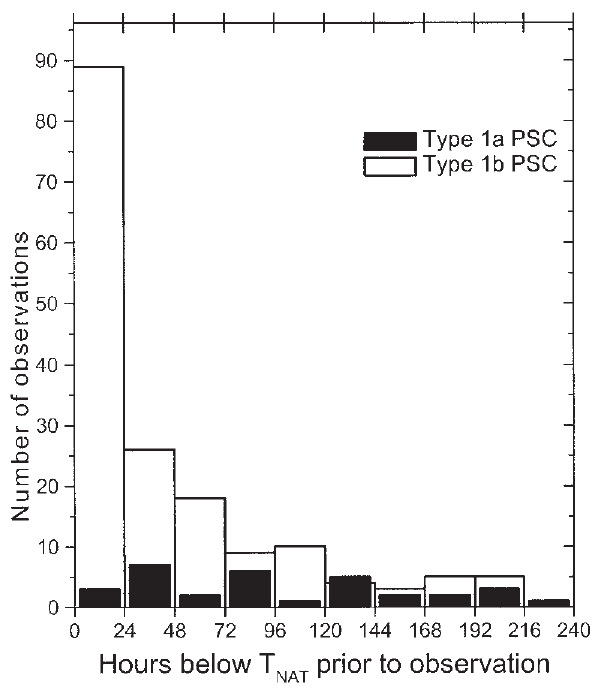
Fig. 9. Histogram showing the time that solid type 1a (fi lled bars) and liquid type 1b PSC particles (open bars) have spent at temperatures below T being